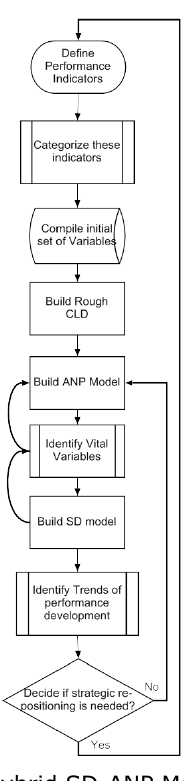
Figure 1. Hybrid SD-ANP